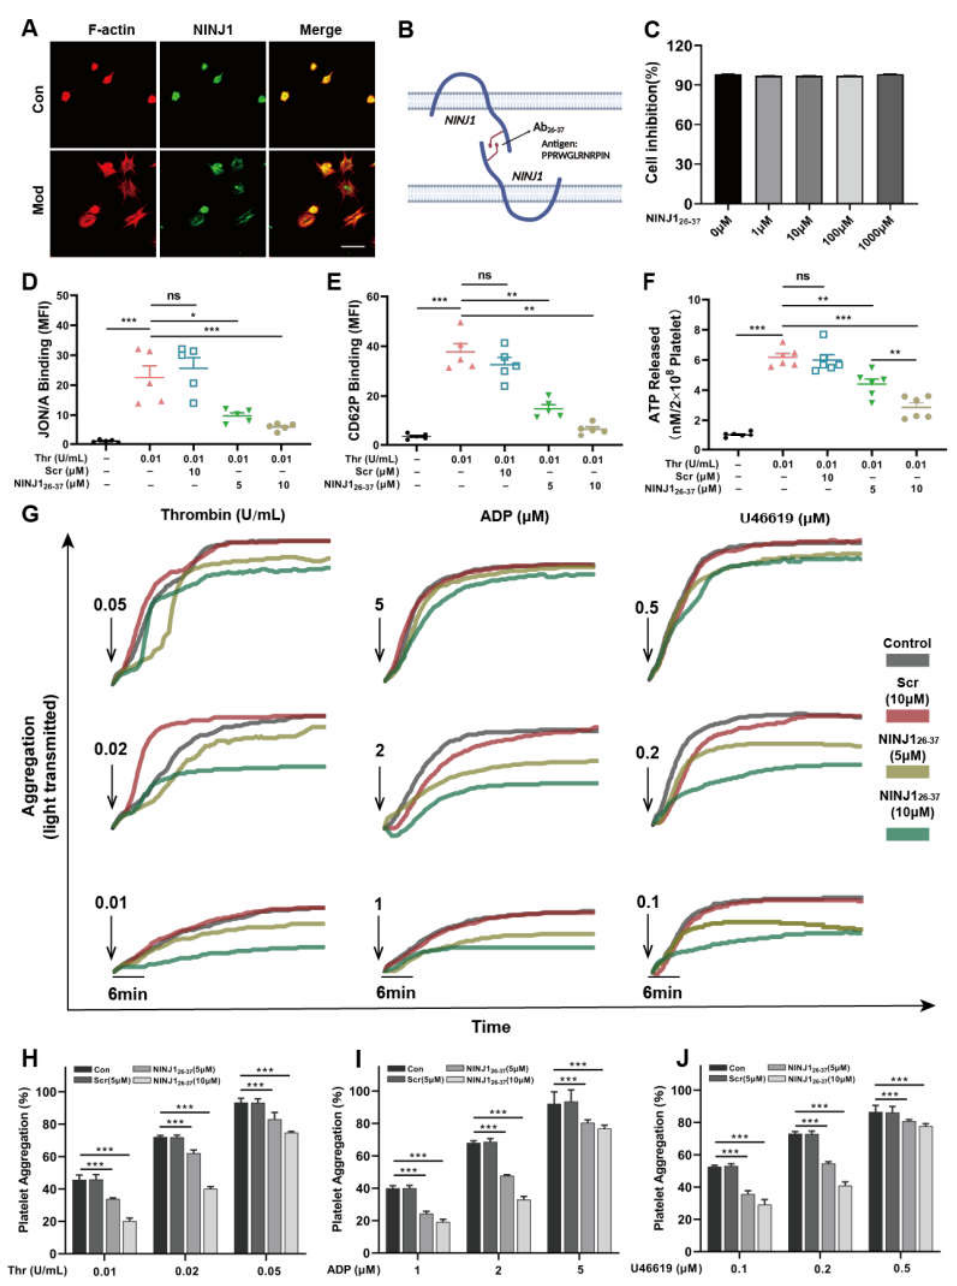
Figure 1. Inhibition of NINJ1 reduces the degree of agonist-induced platelet activation. ( A ) Washed platelets adhere and spread to fibrinogen coated wells by stimulation with thrombin for 1.5 h at 37 ◦ C, model group pre-stimulated with thrombin (0.01 U/mL). After being fixed and stained, the platelets were observed with a fluorescence microscope. Scale bar represents 5 µ m. ( B ) Design of NINJ1 inhibitory peptides. ( C ) Cytotoxicity of NINJ1 inhibitory peptide. ( D ) Effect of inhibition of NINJ1 on integrin α IIb β 3 activation, ( E ) P-selectin exposure, and ( F ) ATP secretion in thrombin (0.01 U/mL) stimulated-platelets. Values are mean ± SEM, n = 5. ns = p > 0.05, * p < 0.05, ** p < 0.01, *** p < 0.001. ( G ) Washed platelets in the presence of fibrinogen pre-treated with vehicle, Scr (10 µ M) or NINJ1 26–37 (5 or 10 µ M) and stimulated with ( H ) thrombin (0.01, 0.02, or 0.05 U/mL), The different colors of the groups information shown on the right. ( I ) ADP (1, 2, or 5 μM), and ( J ) U46619 (0.1, 0.2, or 0.5 μM). The groups information represented by the different color bars is shown at the top of the figure. Results are expressed as the percentage change in light transmission with respect to the blank (buffer without platelets), set at 100%. Values are mean ± SEM, n = 5. * p < 0.05, ** p < 0.01, *** p < 0.001. One-way ANOVA followed by Tukey’s multiple comparisons test.